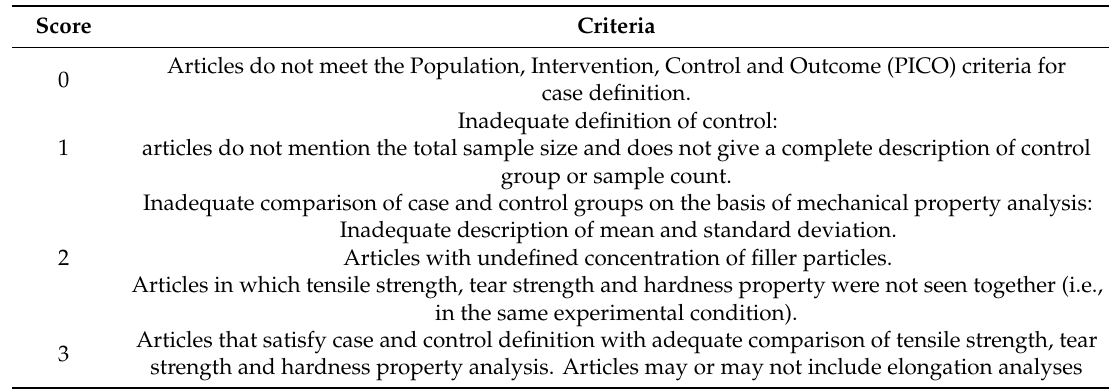
Table 1. Scoring criteria on paper eligibility for